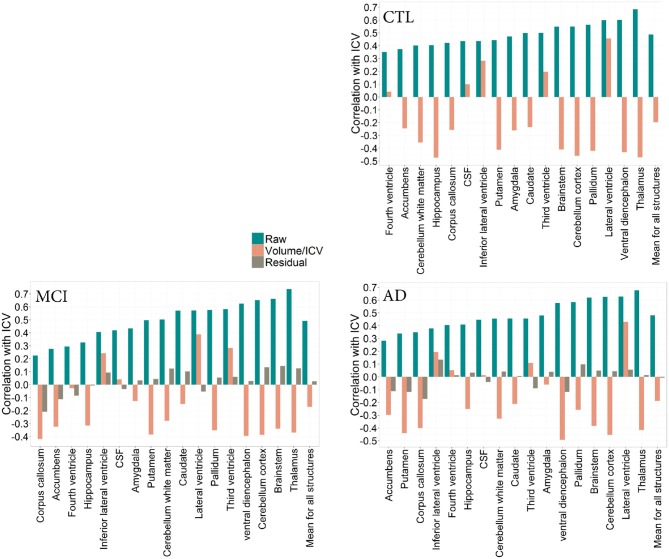
CTL: Correlation patterns created for individual regional subcortical volumes in the CTL subset of the ADNI cohort using different normalization methods. Mean correlation coefficients: Rraw(CTL) = 0.49(0.10), Rproportion(CTL) = −0.19(0.30) MCI: Correlation patterns created for individual regional subcortical volumes in the MCI subset of the ADNI cohort using different normalization methods. Mean correlation coefficients: Rraw(MCI) = 0.49 (0.15), Rproportion(MCI) = −0.17(0.26), Rresidual(MCI) = 0.02(0.10). AD: Correlation patterns created for individual regional subcortical volumes in the AD subset of the ADNI cohort using different normalization methods. Mean correlation coefficients: Rraw(AD) = 0.49 (0.15), Rproportion(AD) = −0.19 (0.27), Rresidual(AD) = 0.007 (0.09).